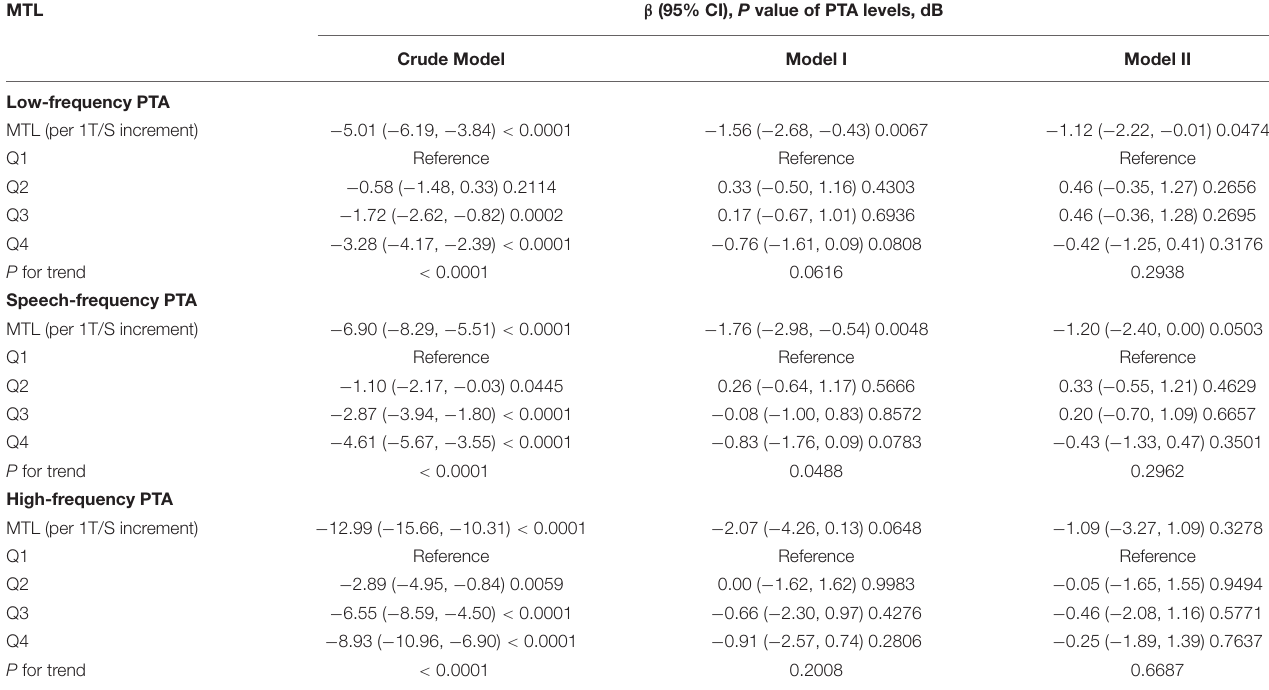
TABLE 3 | Multivariable linear regression models for outcome of hearing thresholds.